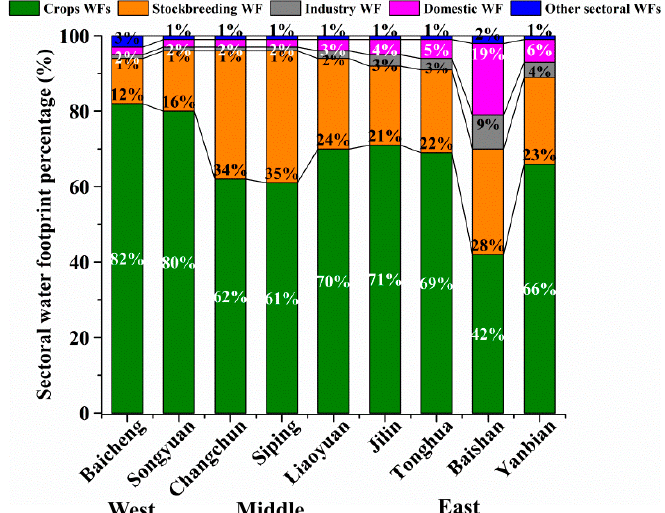
Figure 5. Sectoral WF percentage in Jilin Province in 2015 (West includes Baicheng and Songyuan; Middle includes Changchun, Siping and Liaoyuan; East includes Jilin, Tonghua, Baishan and Yanbian) .